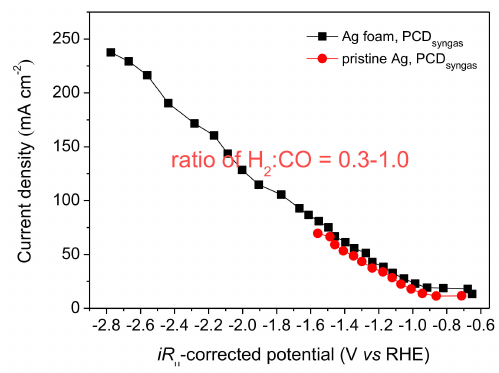
Figure 8. Current density of syngas at the ratio of 0.3–1.0 H 2 :CO for Ag foam and pristine Ag electrodes as a function of potential. Experimental conditions: anolyte, 0.5 M NaOH; catholyte, CO 2 -saturated 0.1 M KHCO 3 ; 25 ◦